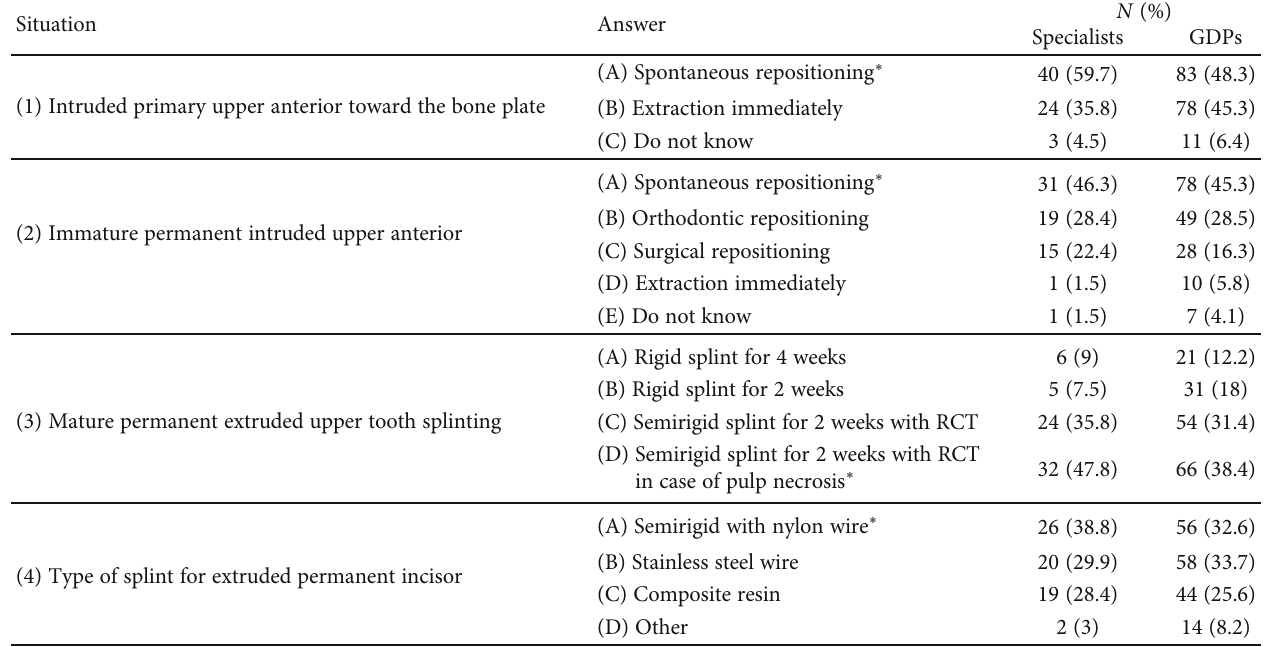
Table 2: Frequency distribution (%) of dentists ’ answers about emergency management of luxated